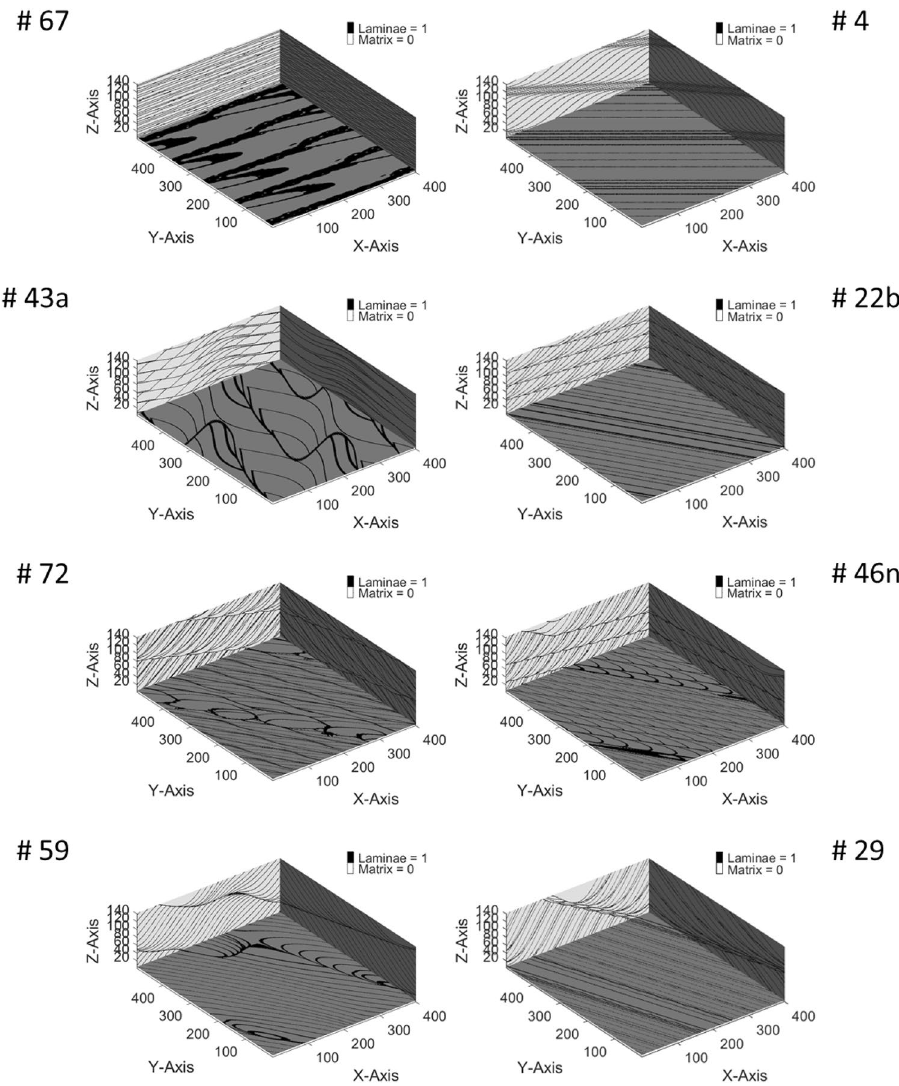
Figure 2. Visualization of eight selected 3D two-facies BAMs 38–40